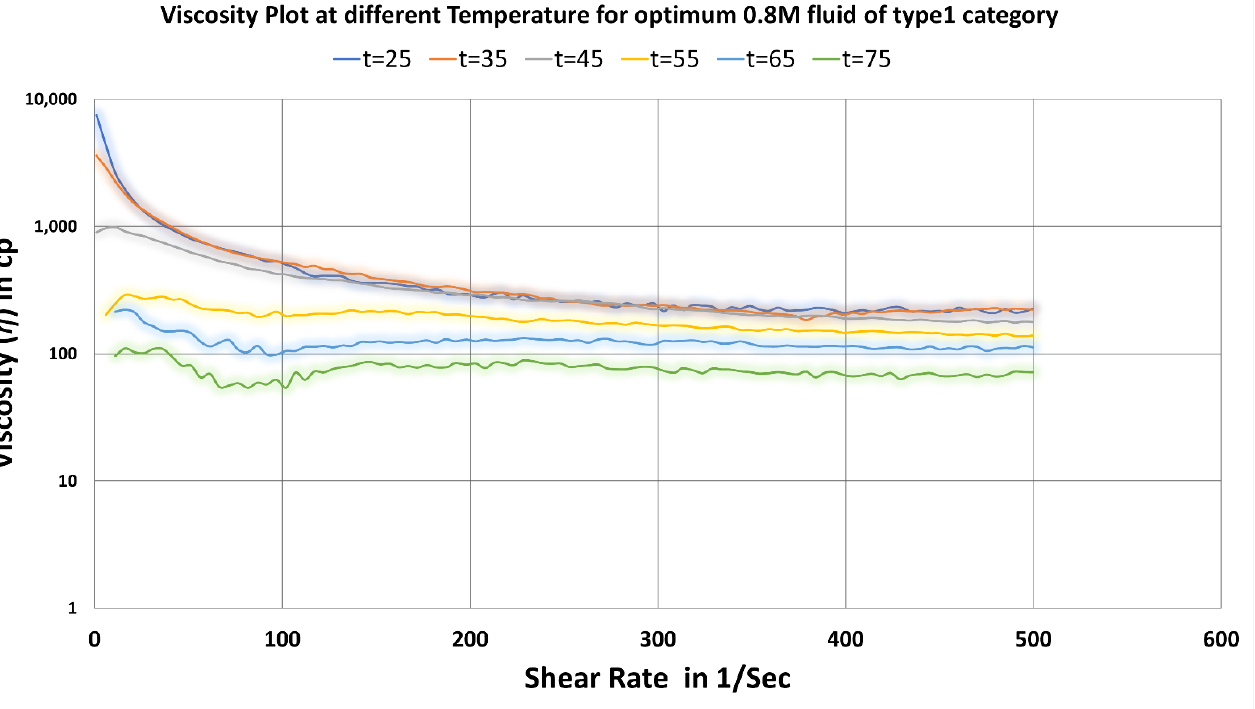
7 of 21 Figure 5. Comparison of viscosity plot of type1 viscoelastic fluids containing 0.8 M and 1.0 M NaNO 3 concentration at different temperatures. The statistical analysis of the plotted data gives different correlations between vis- cosity and shear rate with a considerable coefficient of determination values (see Table 1). Table 1. Regression functions for viscosity change with a varying shear rate of different viscoelas- tic type1 fluids at Temperature 25 °C. Sr. No. Fluid Regression Function Statistical Coefficient of Determination (R 2 Value) 1